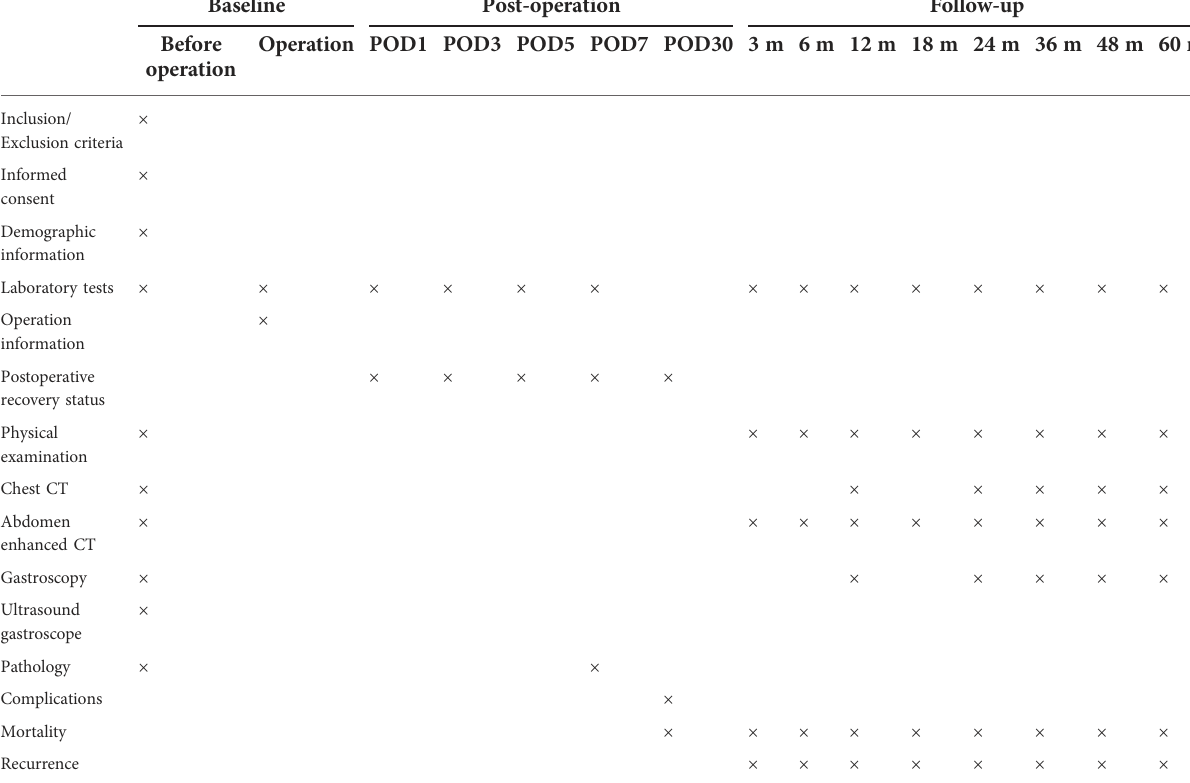
TABLE 1 Checklist for clinical data collection and follow-up plan of enrolled patients.